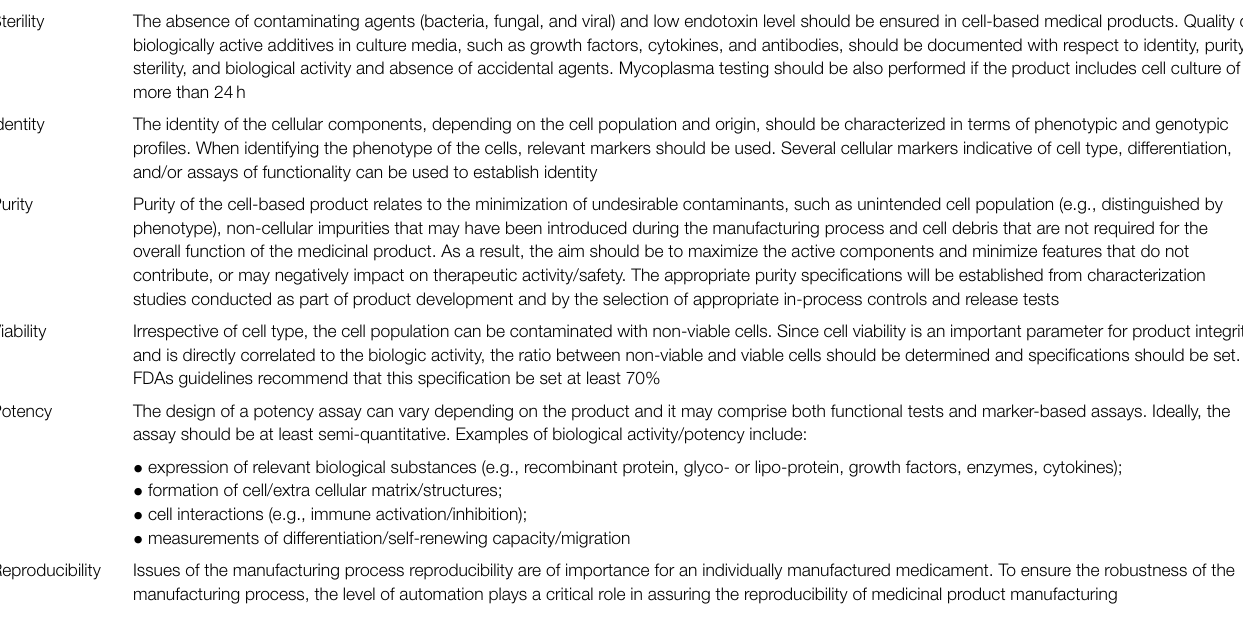
TABLE 2 | Guidelines and definition of product quality